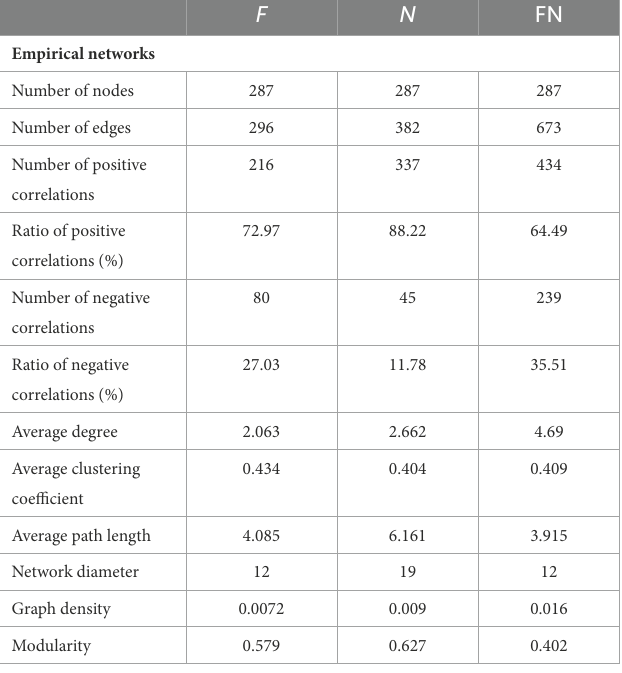
TABLE 3 Topological properties of rhizosphere bacterial networks obtained from different microbial inoculants treatments.